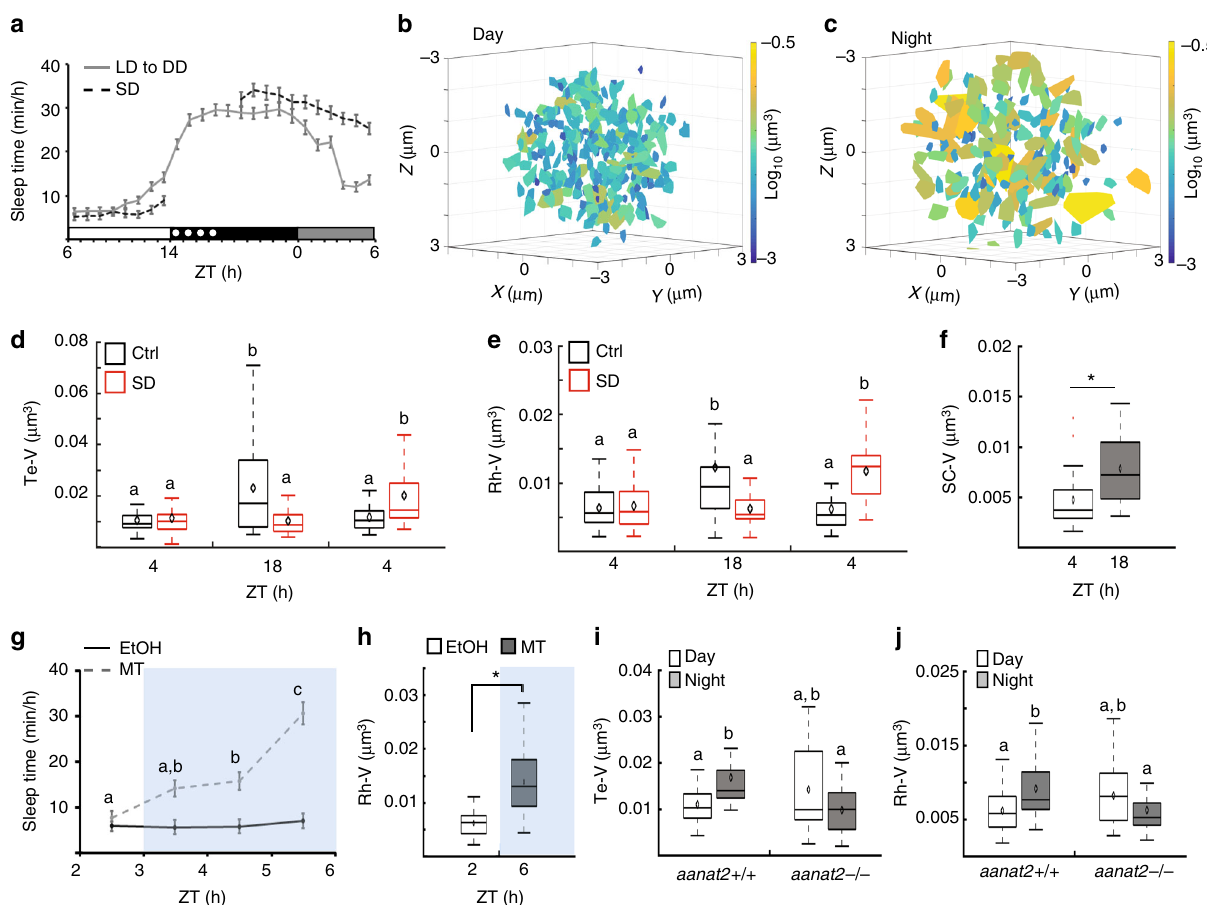
Fig. 2 Sleep increases chromosome dynamics in neurons. a Recording of sleep was performed in 6 dpf control or sleep-deprived larvae under an 14 h light/ 10 h dark cycle following by constant darkness (LD to DD, control: n = 119 larvae, sleep deprivation (SD): n = 96 larvae). b , c The area scanned by all chromosomes from all imaged Te neurons during 9.5 min (day: n = 26 cells; night: n = 29 cells). Color was coded according to the levels of volume of motion. d – f Volume of chromosome dynamics over 9.5 min per cell (EGFP-Terfa in d and e , EGFP-Cenpa in f ). d Te neurons, ctrl: day ( n = 26 cells),